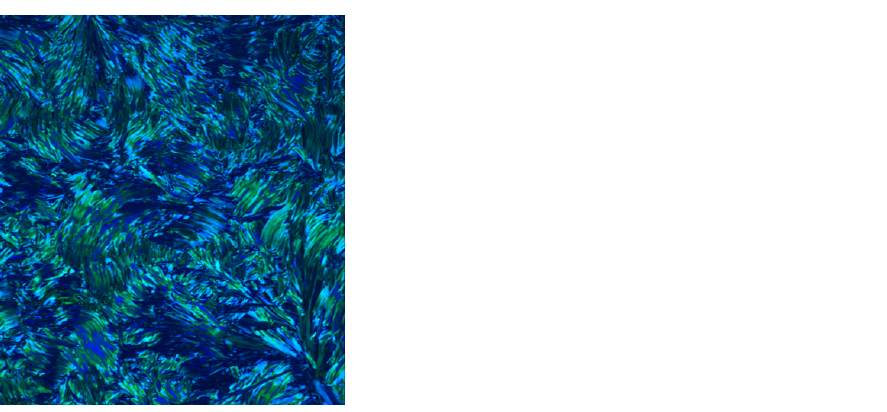
Figure 5. FCPM image for pure MHPOBC material in the mid-thickness of the sample at room tem-